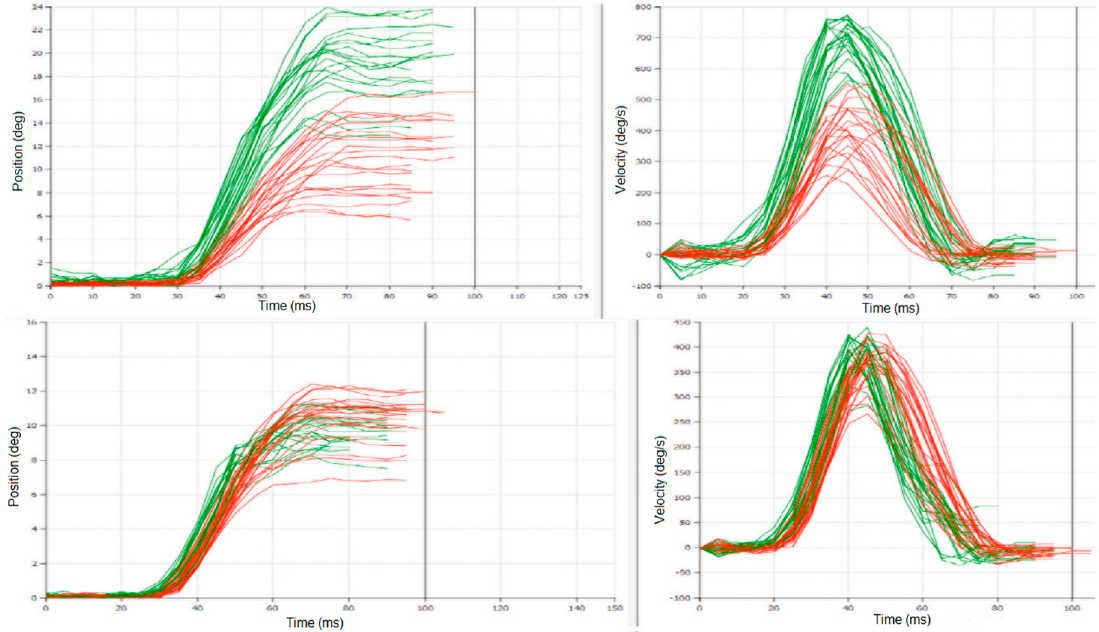
Figure 1. An example of experimental recordings from Pat #38 in two sessions: upper plots from session S1: MedOFF & StimOFF; lower plots from session S4: MedON & StimON; left plots show latency measurements, right plots—saccade amplitude and velocity. Notice change in variability of responses between S1 and S4. These plots were obtained directly from the saccadometer (Ober Consulting), different colours are related to different eyes.